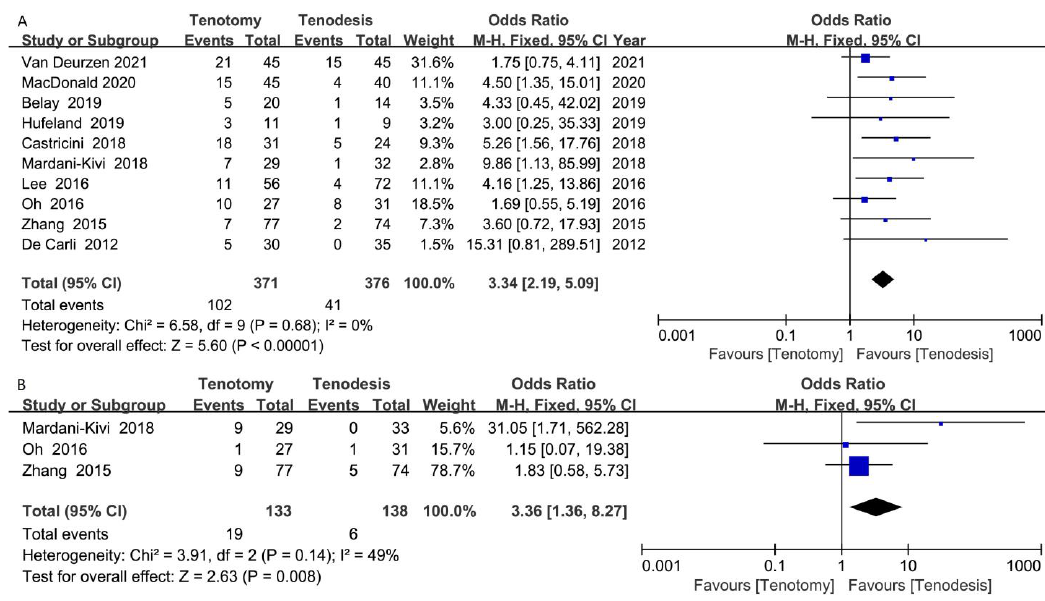
Figure 7. Meta-analysis of ( A ) Popeye deformity; ( B ) cramping bicipital pain. Blue symbol: odds ratio; Black symbol: result of meta-analysis